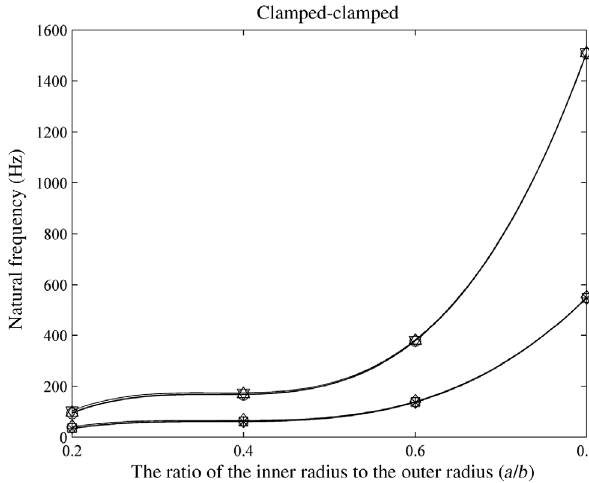
variations on the natural frequency of the disc Figure 4 Effects of n 3 for (A) S-S, (B) C-S, and (C) S-C boundary conditions. * ( m = 0; n = 1), ○ ( m = 0; n = 2), □ ( m = 1; n = 1), ∆ ( m = 1; n = 2), ◊ ( m = 2; n = 1), ∇ ( m = 2; n = 2).